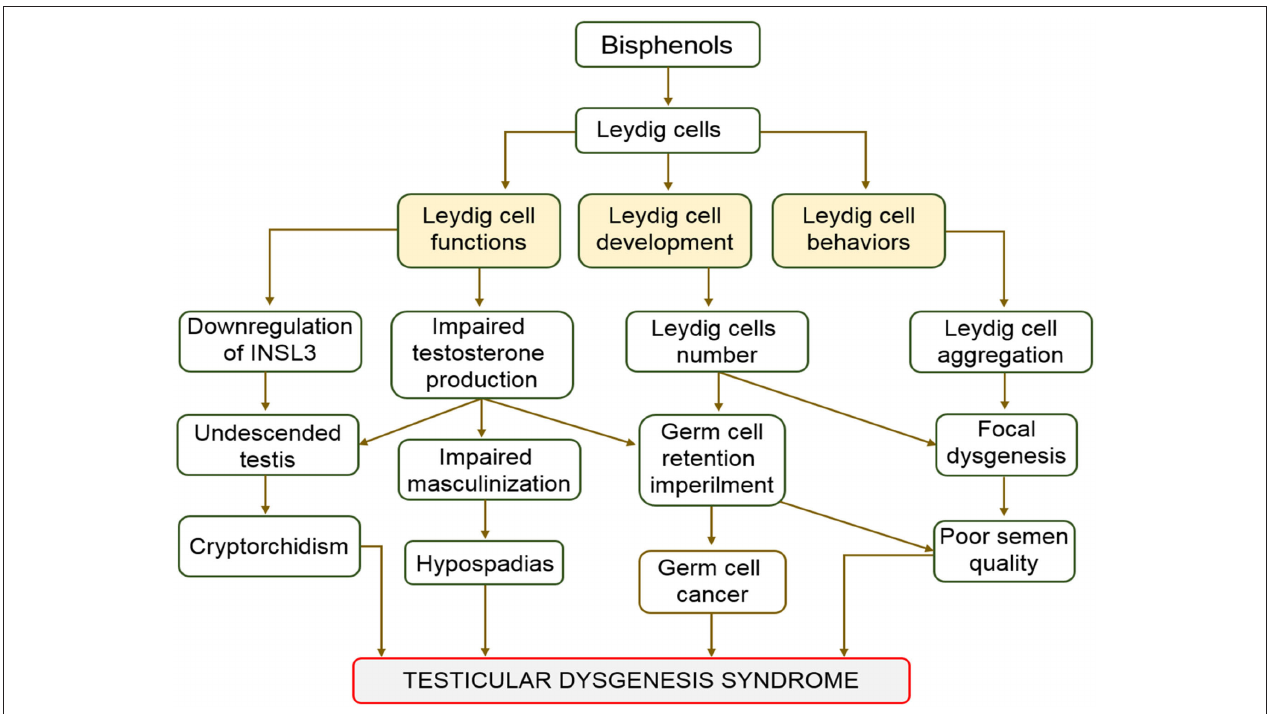
FIGURE 2 | Schematic diagram of the effect of Bisphenols on Leydig